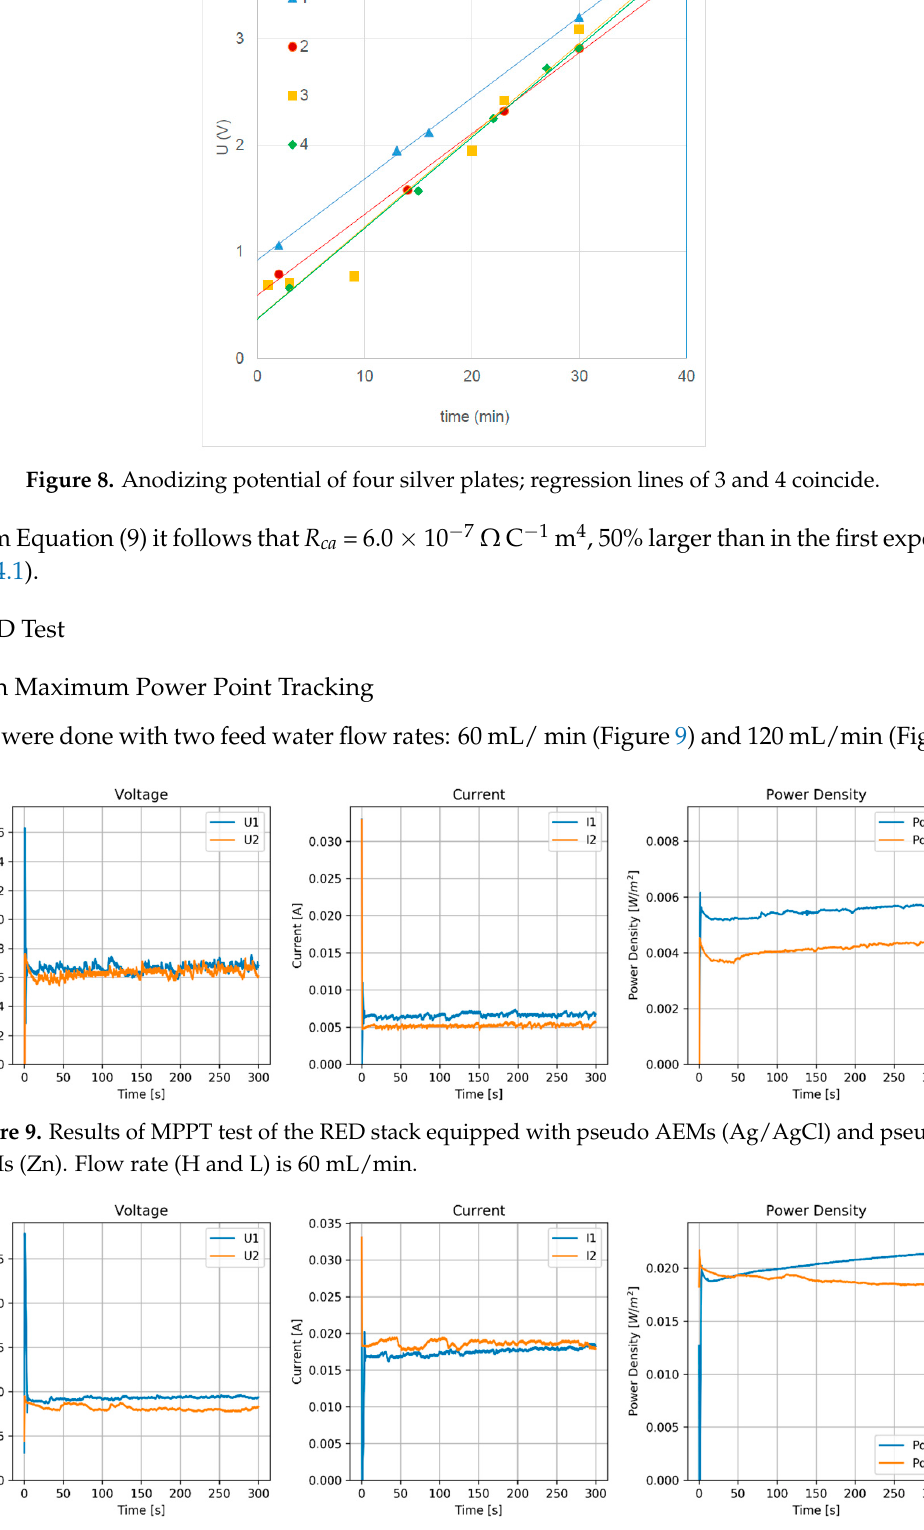
Table 10. Properties of the anodizing regression lines from Figure 8.